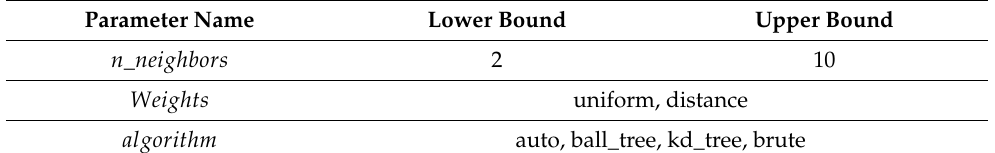
Table 7. An overview of the used hyper-parameter range for K-Neighbors Regression